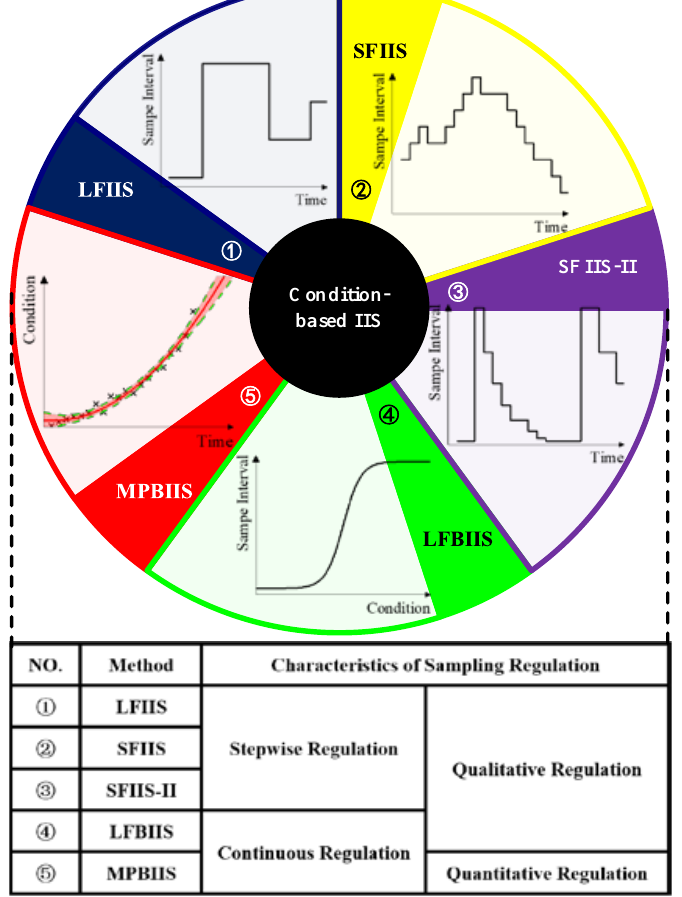
Figure 3. A sketch map and the characteristics of Condition-based IIS.